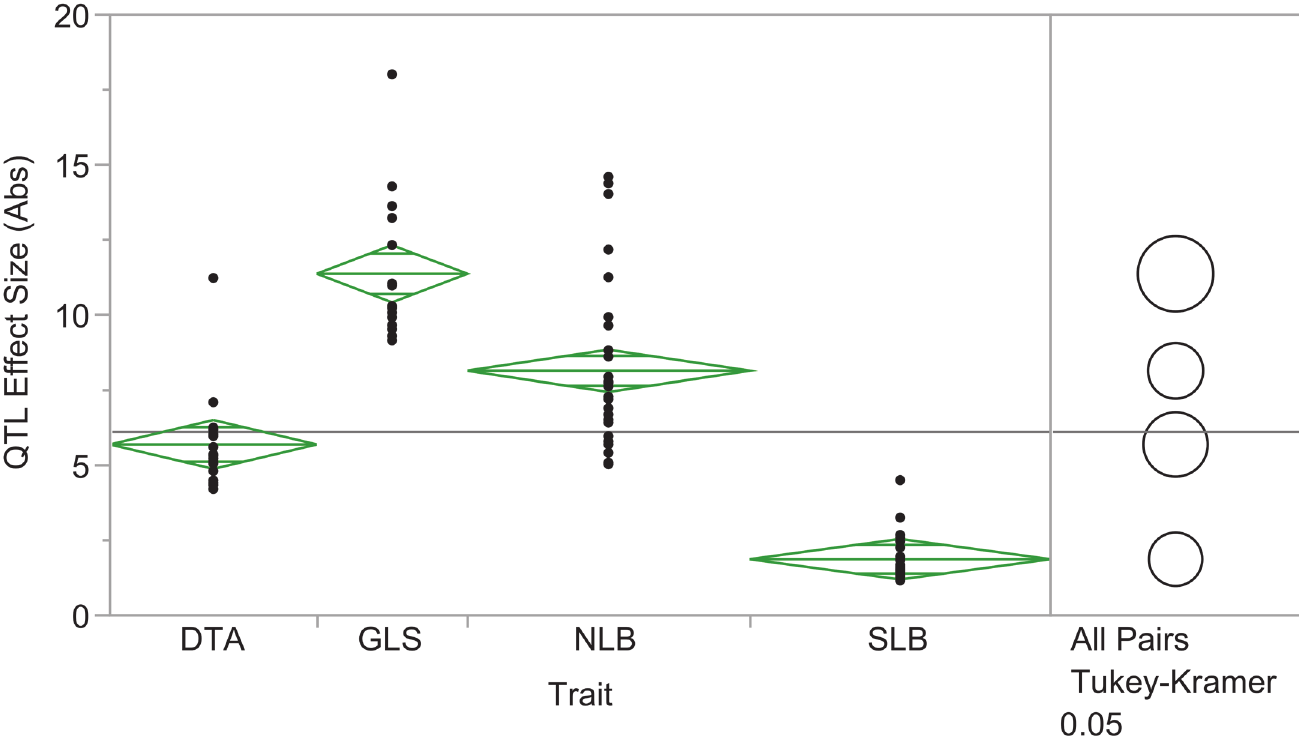
Fig 4. Absolute value of quantitative trait loci (QTL) effect size across three diseases and flowering time. Effect sizes of QTL for gray leaf spot, northern leaf blight, southern leaf blight and Blacksburg specific days to anthesis were significantly different ( p = 6.33x10 – 30 ).